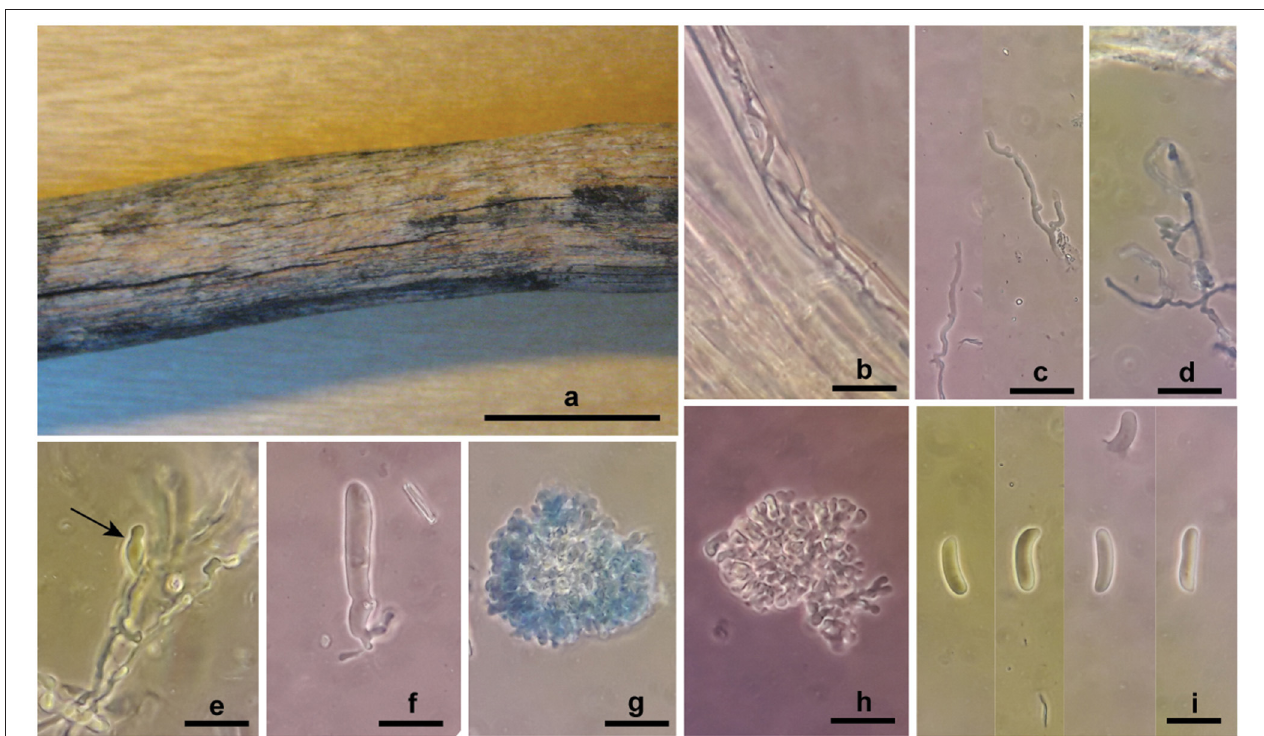
FIGURE 8 | Marchandiomyces allantosporus sp. nov. from holotype. (a) Basidiomata; (b) hyphae in wood vessel; (c,d) hyphae; (e) basidiole (arrow); (f) basidium; (g,h) hyphelium; (i) basidiospores. Scale bars, (a) 1cm; (b–i) 20 µ